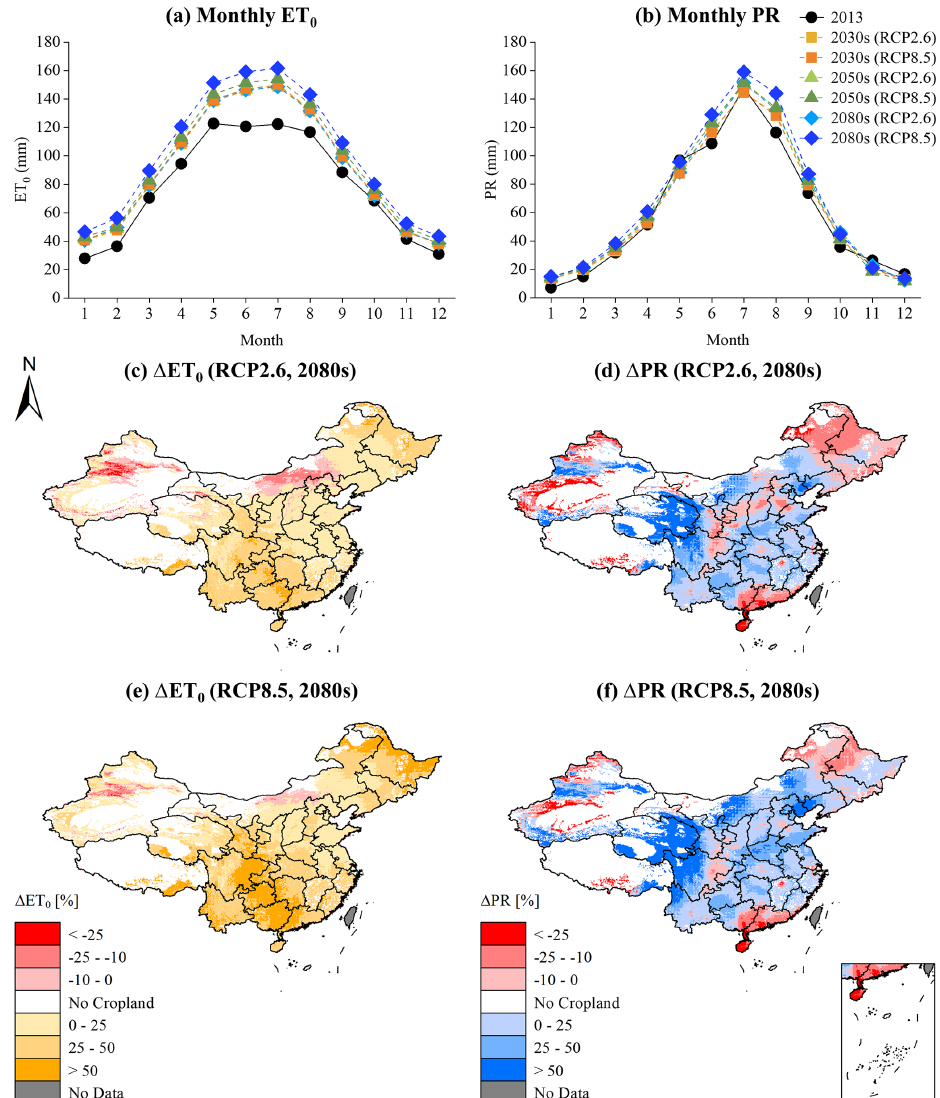
Figure 3. Future climate projections for the zones planted with maize and wheat in